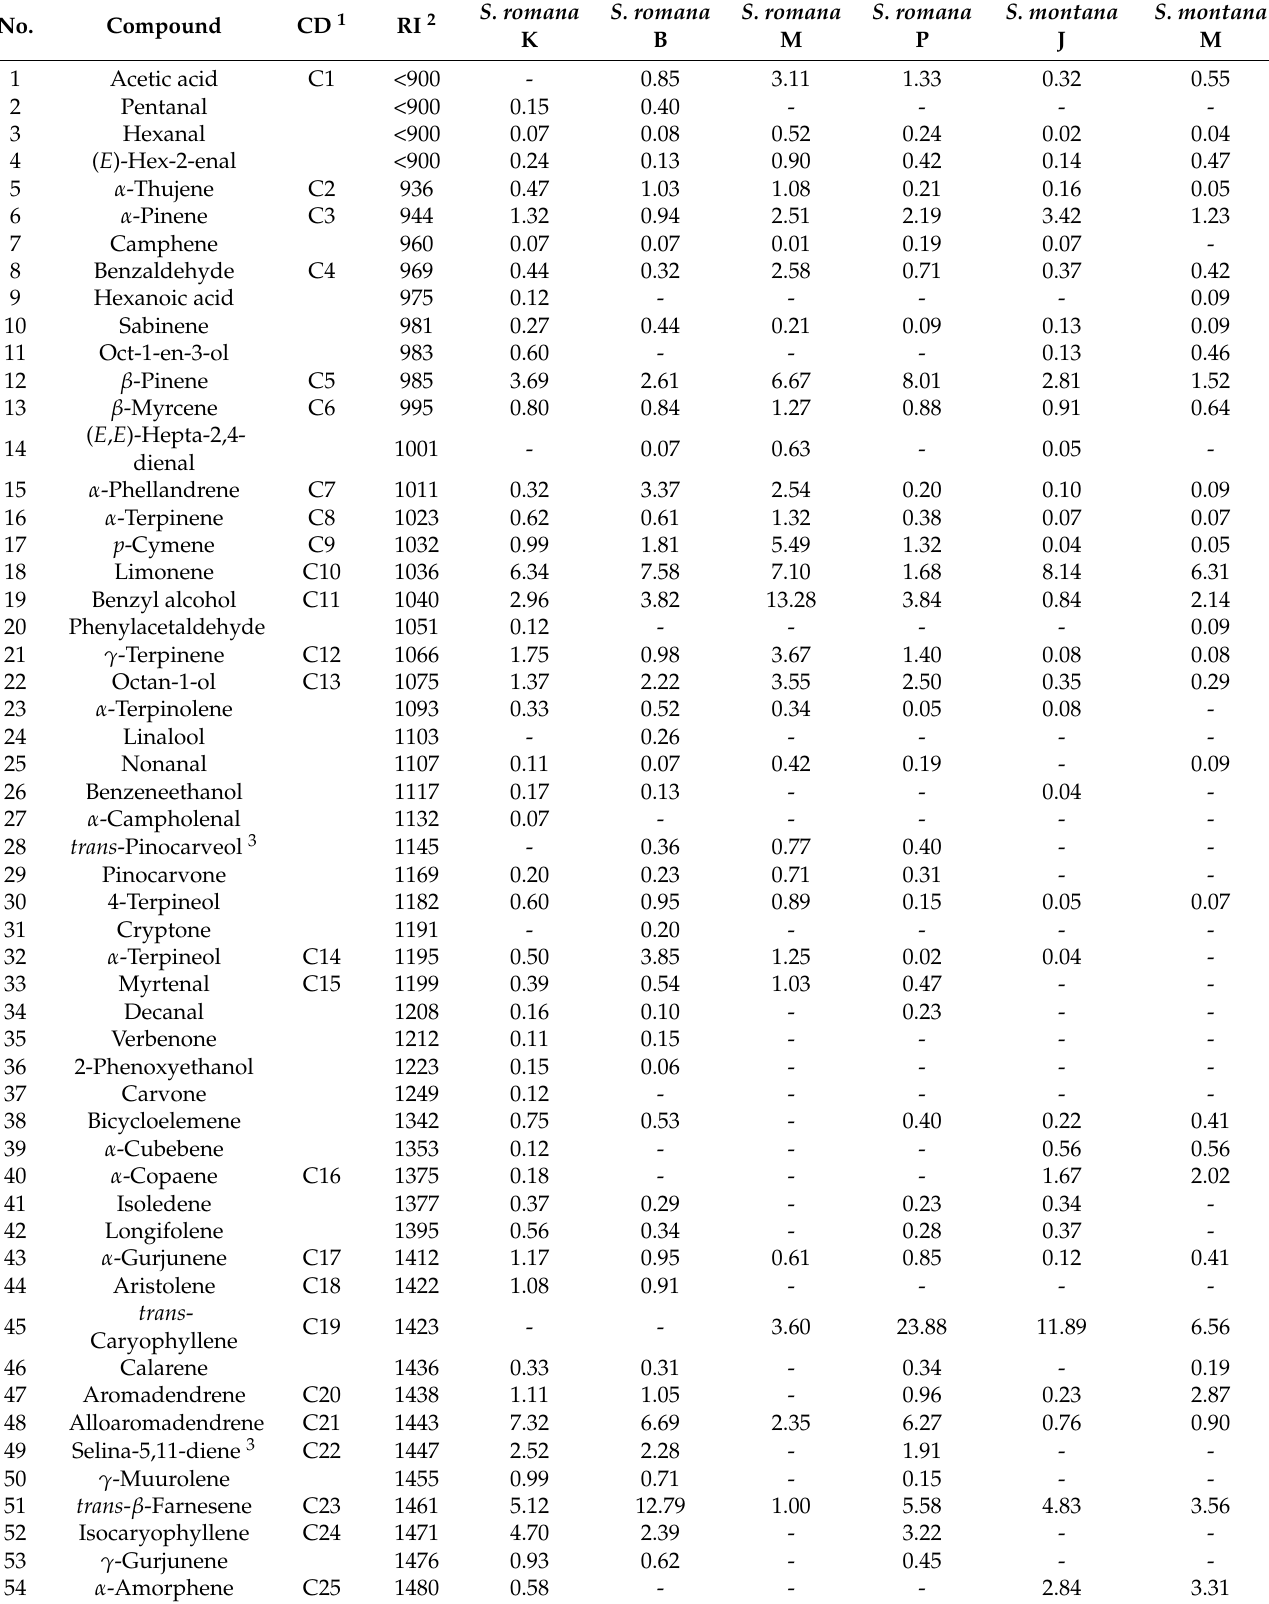
Table 1. Volatile organic compounds (VOCs) composition (%) of S. romana and S. montana obtained by HS-SPME/GC-MS with DVB/CAR/PDMS